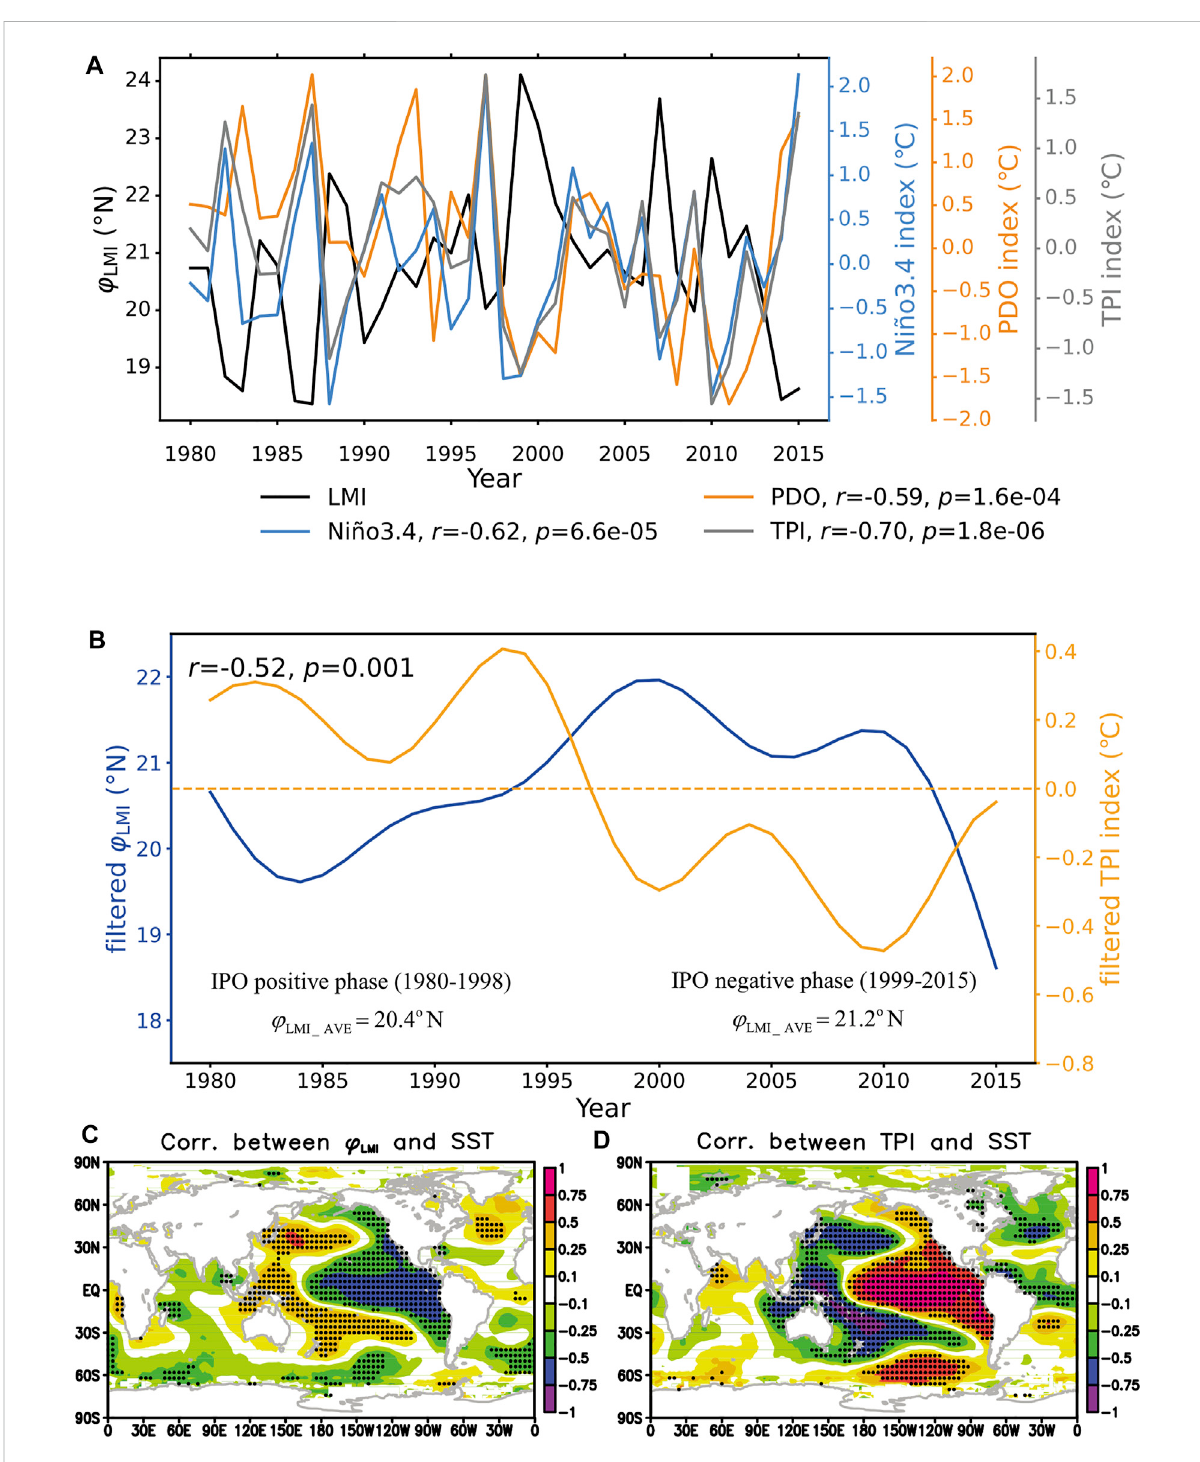
FIGURE 2 RelationshipbetweenthelocationofLMIovertheWNPandtheIPO. (A) Timeseriesofannual-mean φ LMI fromtheIBTrACSbest-trackdata(blackline) and JASON-mean TPI (grey line), Niño3.4 index (blue line), PDO (orange line); (B) Low pass fi ltered time series of TPI (orange line) and φ LMI (blue line); (C) mapofcorrelationcoef fi cientbetweentheannual-mean φ LMI andJASONSST;and (D) mapofcorrelationcoef fi cientbetweentheJASONTPIandJASON SST.Thecorrelationcoef fi cients(i.e., r )between φ LMI andTPIor fi lteredTPI,andthe p -value(i.e., p )fortestingthehypothesisofnocorrelationarealso showninFigures 2A,B(annotatedvalues).A 13-yearsChebyshevlow-pass fi lter isappliedtoobtainthe fi lteredversionof thetwo indices. ThepositiveIPO phasecorrespondstotheperiodwhenthe fi lteredTPIisnolessthan0 ° C(i.e.,1980 – 1998),whiletheIPOnegativephasecorrespondstotheperiodwhen the fi lteredTPIislessthan0 ° C(i.e.,1999 – 2015).Thetime-averaged φ LMI inthetwoIPOphasesarepresentedinFigure2B(annotatedvalues).Dottedareas in Figures 2C,D denote that the differences are signi fi cant at/above the 95% con fi dence level by the Student ’ s t